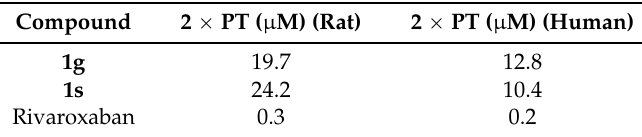
Table 2. The anticoagulant activity of 1g and 1s